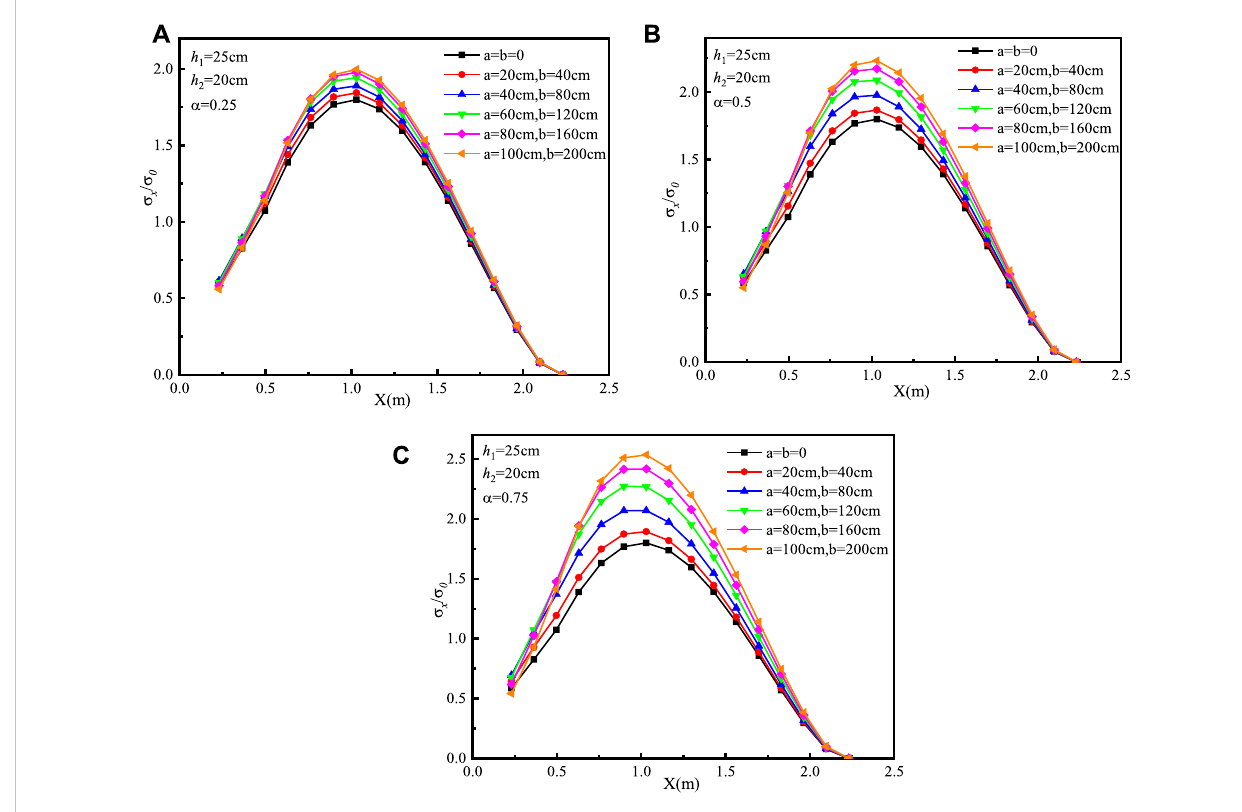
FIGURE 6 Dimensionlesstensile stress distributionof the pavement using theMFBM with h 1 = 25 cm and h 2 = 20 cm: (A) α = 0.25, (B) α = 0.5, and (C) α = 0.75.